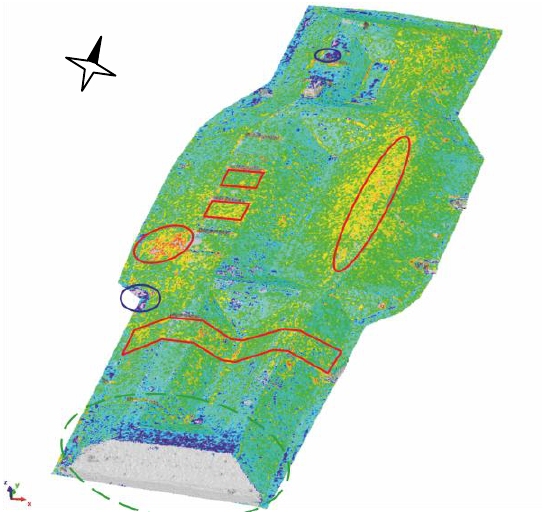
Figure 2. Color schema legend for comparison of UAV-DSM minus TLS-DSM with a range of ±7.0 cm.